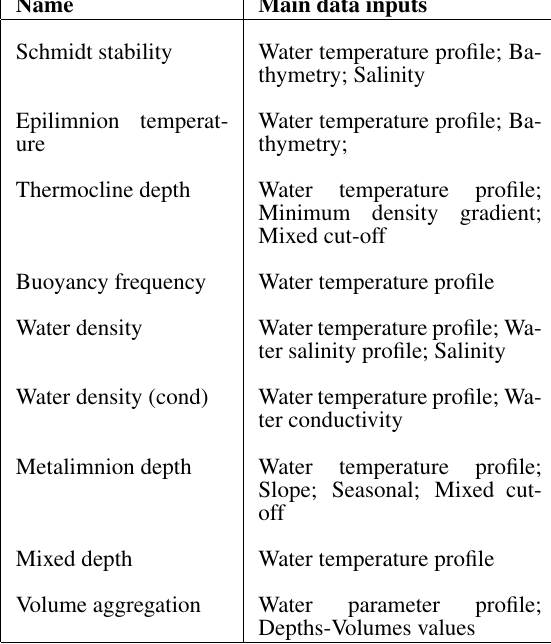
required to mix the water column uniformly over depth. The algorithm was theorized by Schmidt (Schmidt, 1928) and was improved and modified by Hutchinson and Idso (Hutchinson, 1957, Idso, 1973). The result is a mixing energy required per unit